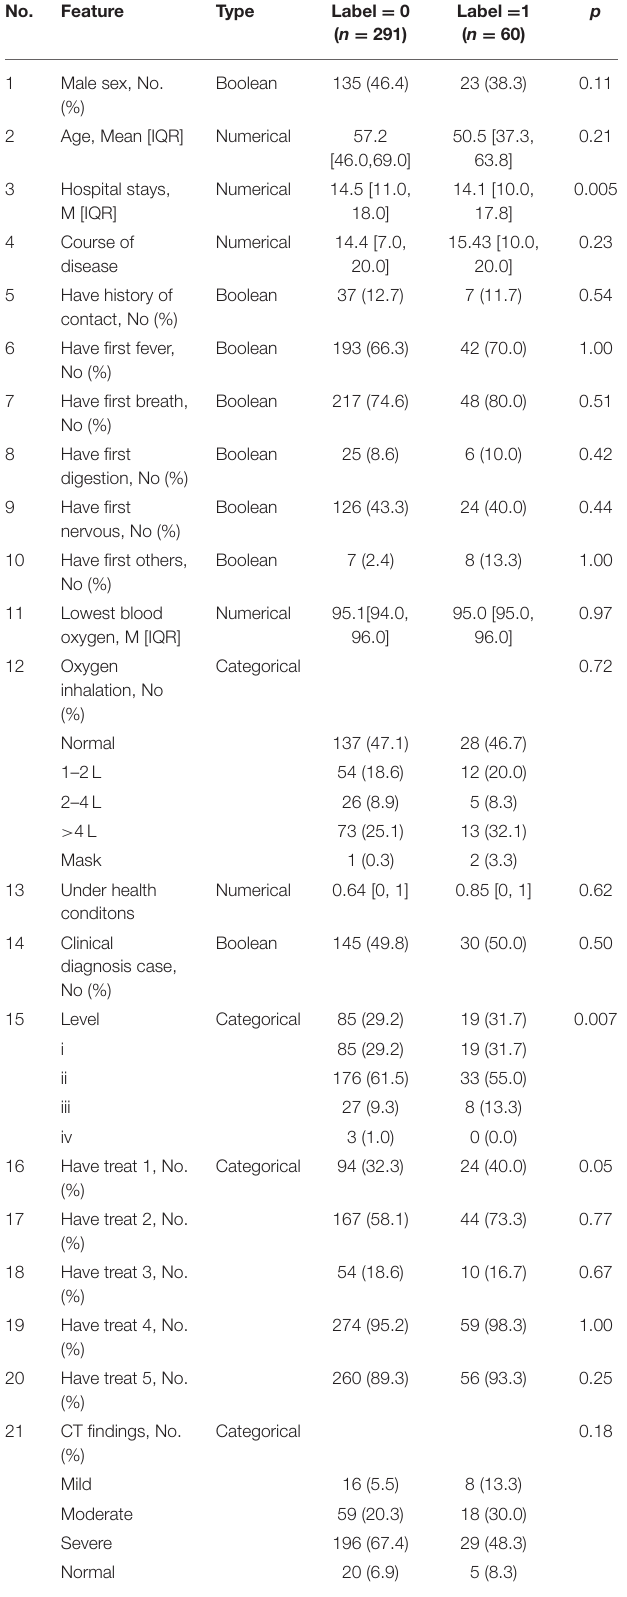
TABLE 2 | Description of features in two